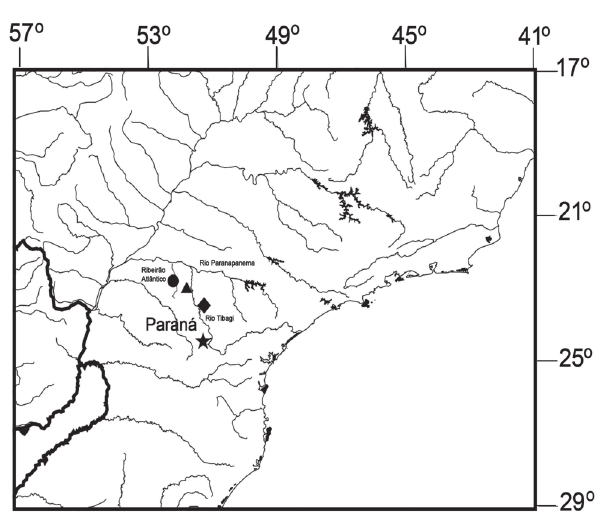
Fig. 1. Partial map of South America showing the collecting sites of Neoplecostomus yapo . Circle = ribeirão Atlântico, município de Mandaguaçu; triangle = ribeirão Uraí, mun. Londrina; lozenge = rio Fortaleza, mun. Tibagi; and star = rio Verde, mun. Ponta Grossa, Paraná